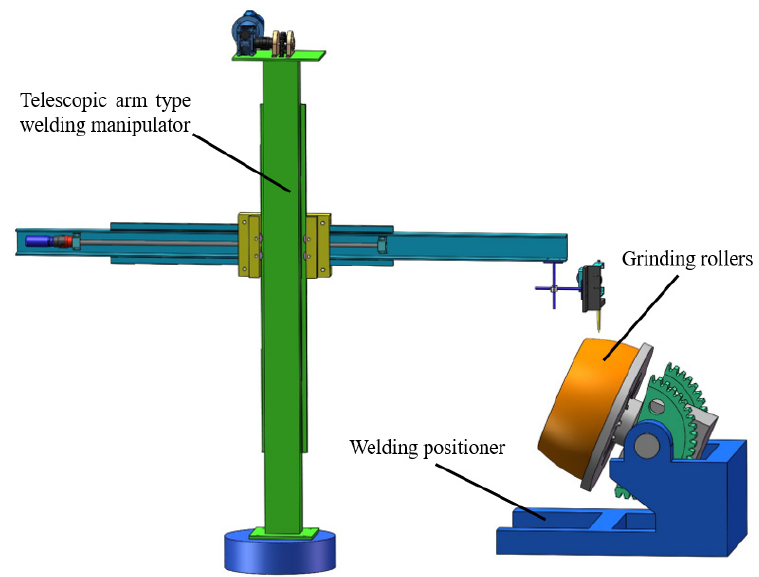
Figure 7. G rinding roller surfacing equipment. Figure 7. Grinding roller surfacing